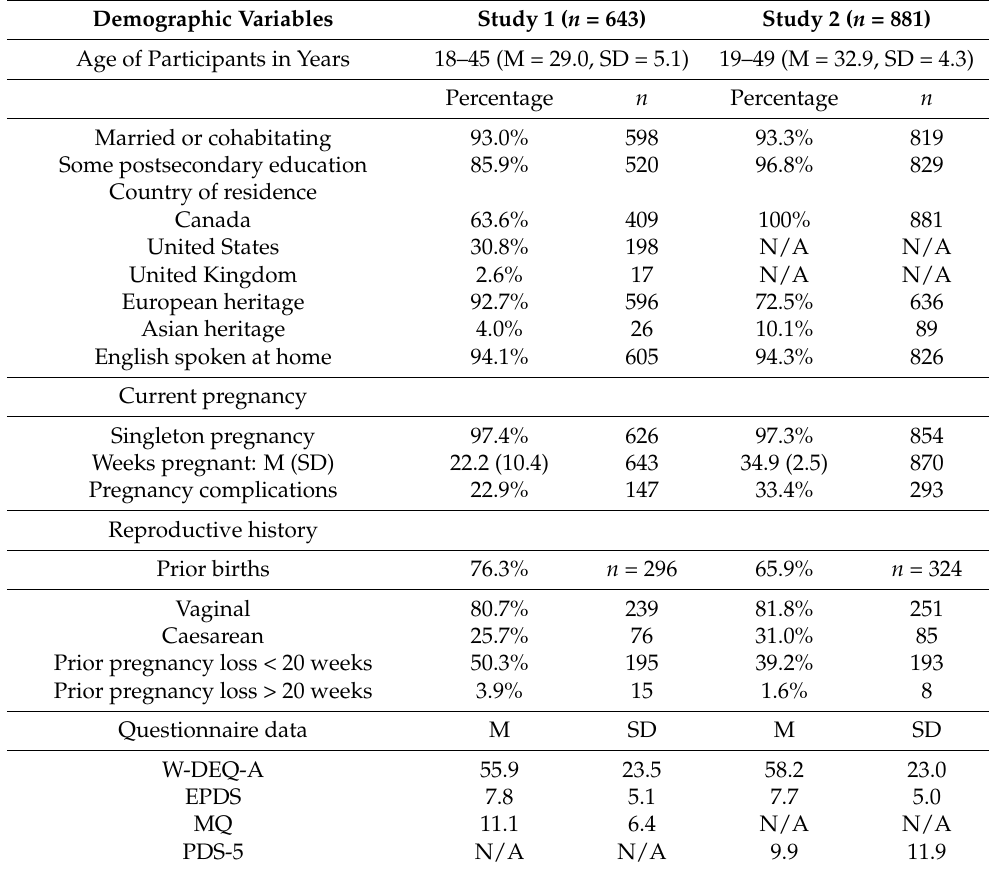
Table 2. Participant demographic and reproductive information. M, mean; SD, standard